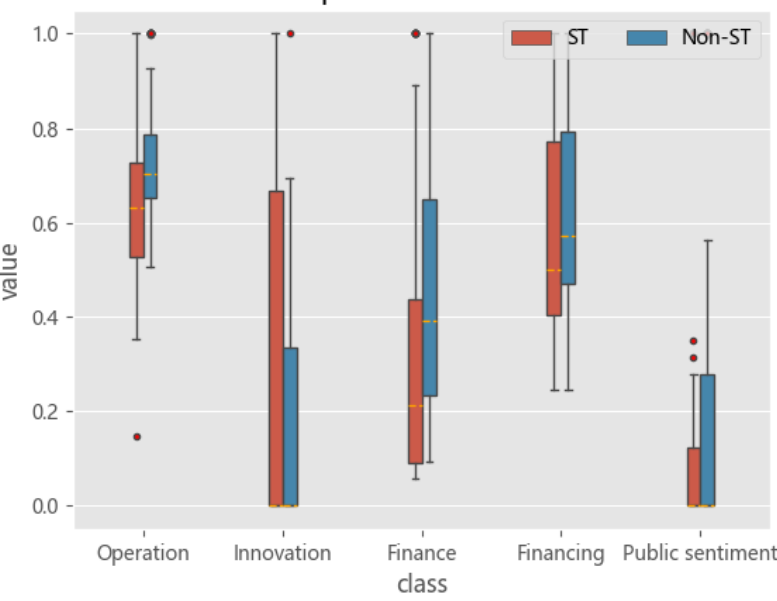
Figure 3. Comparison of efficiency values of listed companies in various dimensions.